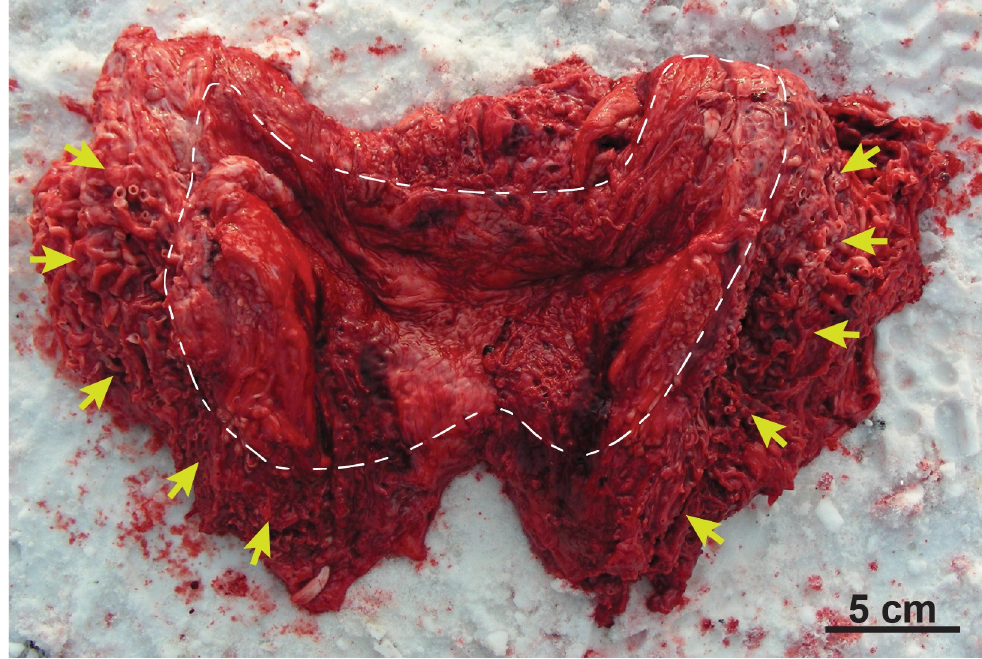
Fig 2. Bowhead rete. Excised section of a bowhead whale (NSB-DWM 2008B11) rete; this portion of the rete is located on either side of the cerebellum; the smooth part of the dura touches the arachnoid (inside white dashed line); yellow arrows indicate the reticulate network of blood vessels that compose the rete.